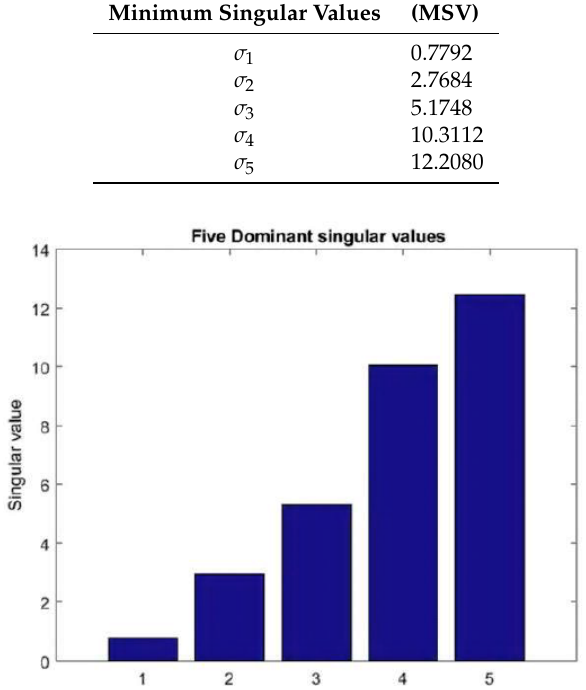
Table 4. First 5 MSVs for all period of wind curtailment: Case II.